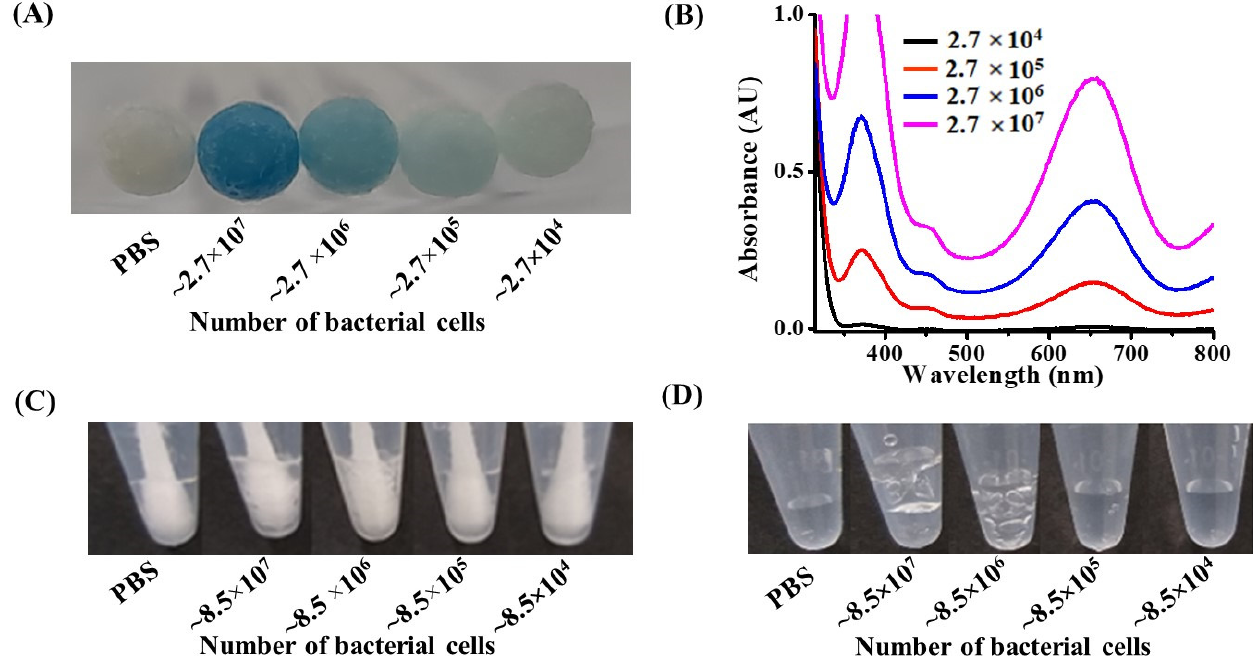
Figure 2. ( A ) Photograph of the cotton swabs obtained after imbuing with the samples (10 µ L) containing E. coli O157:H7 at concentrations of ~5.4 × 10 5 –~5.4 × 10 8 cfu mL − 1 of bacterial cells, prepared at pH 3, followed by dipping into a reagent droplet (50 µ L) consisting of TMB (1.25 mM) and H 2 O 2 (11.2 mM) at pH 3. ( B ) UV–Vis absorption spectra of the bacterial samples (0.2 mL) containing E. coli O157:H7 at concentrations of ~5.4 × 10 5 –~5.4 × 10 8 cfu mL − 1 obtained after reaction with hydrogen peroxide (~11.2 mM) at pH 3 (0.2 mL) for 25 min. ( C ) Photograph of the cotton swabs obtained after sampling S. aureus, at concentrations of ~8.5 × 10 5 –~8.5 × 10 8 cfu mL − 1 , from the samples (0.1 mL) prepared in the phosphate buffer at pH 3, followed by the reaction with H 2 O 2 (180 mM, 0.1 mL) at pH 3. ( D ) Photograph of the bacterial samples (0.1 mL) containing S. aureus at concentrations of ~8.5 × 10 5 –~8.5 × 10 8 cfu mL − 1 cells obtained after reaction with hydrogen peroxide (180 mM, 0.1 mL) prepared in the phosphate buffer at pH 3 for 5 min.